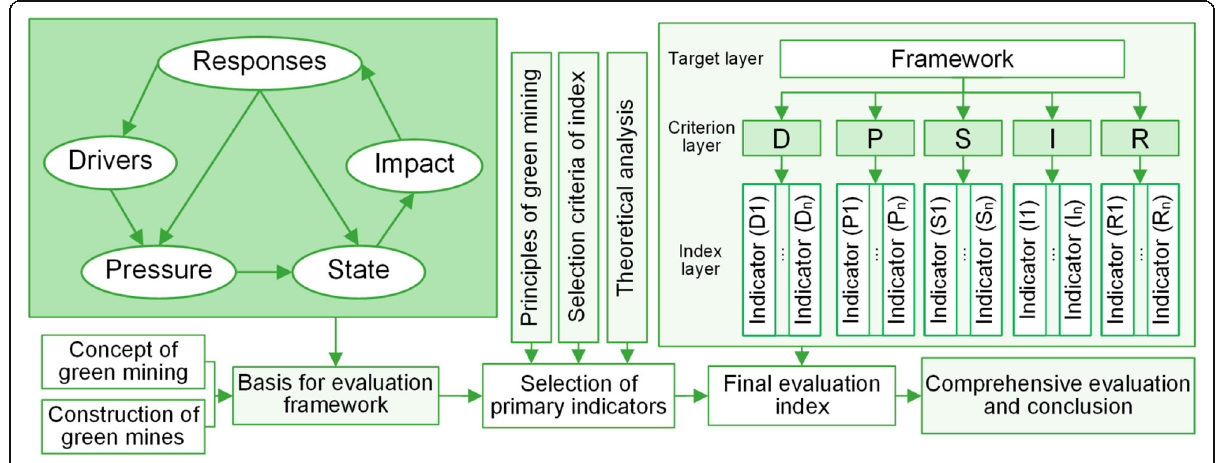
Fig. 1 The framework of the DPSIR